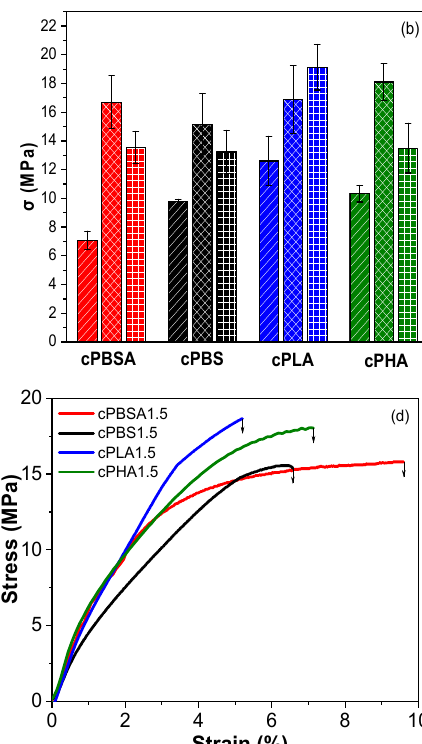
Figure 6. ( a ) Experimental adhesion peel test stress–strain curves for cPBSA1.5 and cPBS1.5 showing the highest and lowest measured values ( b ) picture of prepared laminates for peel test. Packaging materials are often used in a relatively broad temperature range. To char- acterize laminate thermomechanical properties, storage modulus (E’) and tan δ were measured (Figure 7a,b). Storage modulus can be considered relatively similar to elastic modulus values obtained from tensile tests. As can be seen, the general trend is very sim- ilar at room temperature (20 °C). cPHA1.5 shows the highest values, while cPBSA1.5 and